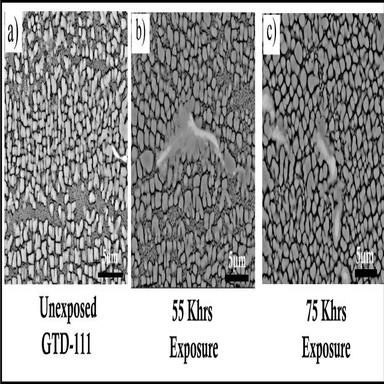
The SEM micrographs of: (a) unexposed GTD-111 alloy, (b) 55,000 h and (c) 75,000 h exposure time.